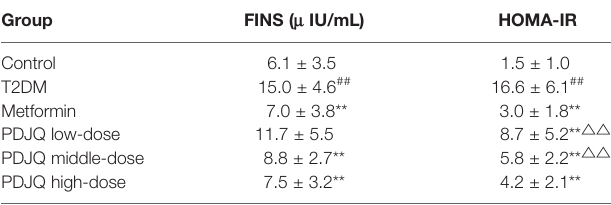
TABLE 3 | Levels of FINS and HOMA-IR after PDJQ